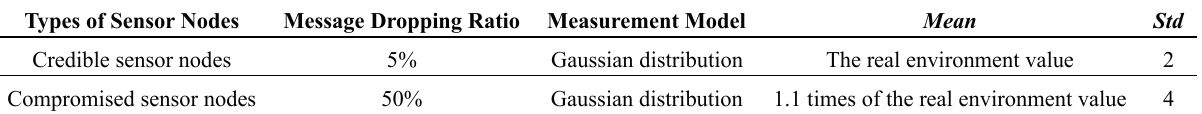
Table 1. Comparisons between credible sensor nodes and compromised sensor